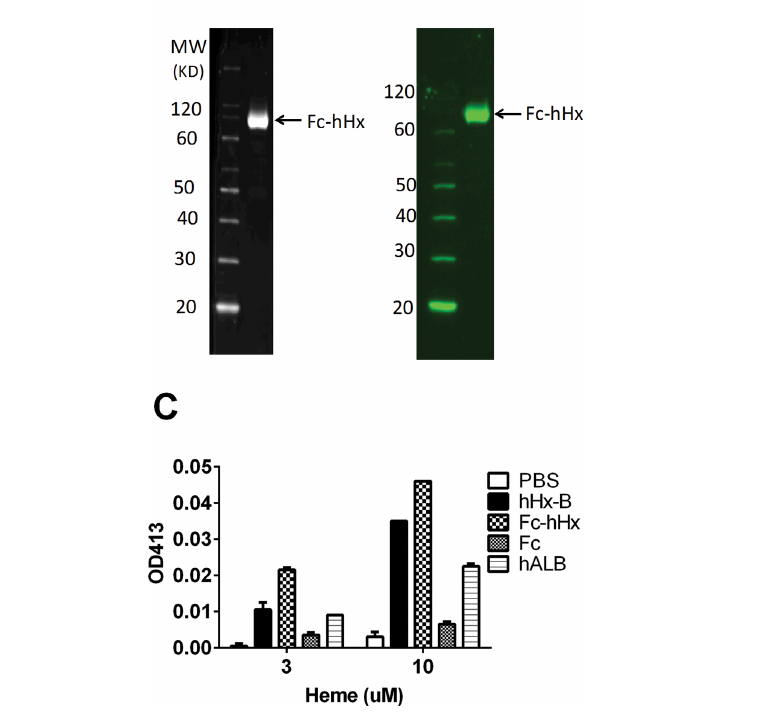
Figure 3. Recombinant Fc-hHx has the same heme-binding activity as purified Hx. Recombinant Fc-hHx prepared as described in Materials and Methods was applied to SDS-PAGE with Coomassie Fluor Orange (Life Technologies) staining (A) and developed as a Western blot with Cy3-labeled goat anti-human Fc antibody (Jackson ImmunoResearch) (B). Fc-hHx is shown in the reduced gels as a high-purity 75-kDa monomer (see arrow). In nonre- duced gels, the Fc-hHx is a 150-kDa dimer (not shown). (C) Heme binding assay was done with 10 μ mol/L of recombinant Fc-hHx; purified hHx-B; Fc fragment of IgG1; human albumin (hALB). All protein samples or PBS were mixed with free heme at different concentrations (3 and 10 μ m) at room temperature for 30 min. The absorbance at 413 nm was measured by Nanodrop ND1000. The results represent the mean ± SE.